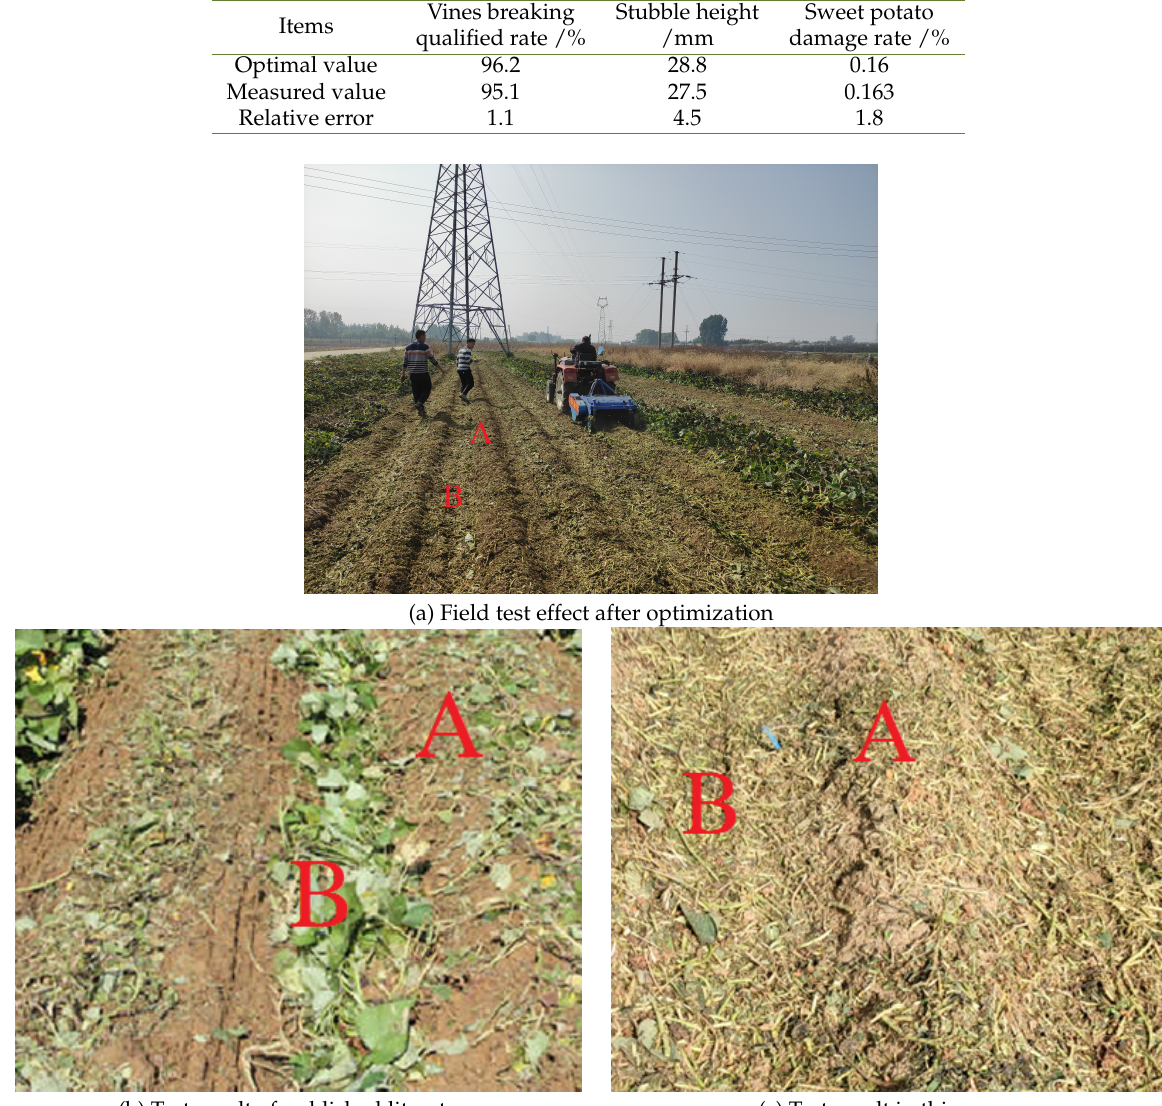
Fig. 12. Field test